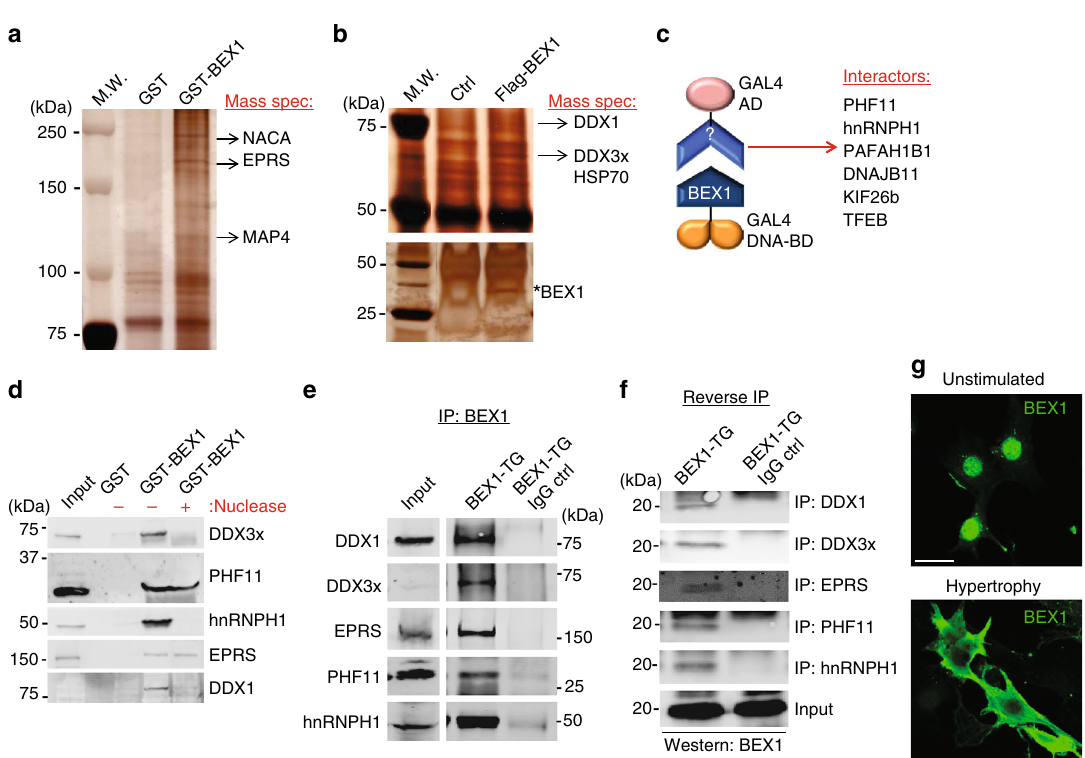
Fig. 3 Annotating the BEX1 protein interactome. a Silver-stained polyacrylamide gel following GST-only or GST-BEX1 pull-down from cardiac protein extracts. Arrows indicate the binding proteins identi fi ed by mass-spectrometry. b Silver-stained polyacrylamide gel following control or Flag-BEX1 immunoprecipitation from neonatal rat cardiomyocytes protein extracts. Arrows indicate the binding proteins identi fi ed by mass-spectrometry. c Schematic of the employed yeast two-hybrid screening strategy. The arrow shows the list of binding proteins identi fi ed. d Western blot following GST-BEX1 pull-down of the indicated proteins from cardiac extracts of WT hearts with or without addition of micrococcal nuclease to degrade RNA. e Western blot for the indicated 5 proteins following immunopreciptation of BEX1 protein from BEX1 transgenic hearts. Input is shown on the left and anti-BEX1 or IgG was used for the immunoprecipitations. f Western blot for BEX1 protein from a BEX1 transgenic heart after immunoprecipitation of the 5 shown endogenous proteins. The input is shown on the bottom and the IgG control is shown in the right lanes. g Immuno fl uorescence for BEX1 (green) in neonatal rat cardiomyocytes in unstimulated (serum-free media) or hypertrophic conditions (media containing 2% serum). Original magni fi cation is 100×. Scale bar is 20 µ m. Abbreviations: DDX3x = DEAD box helicase 3 X-linked; DDX1 = DEAD box helicase 1; hnRNPH1 = heterogeneous nuclear ribonucleoprotein H1; PHF11 = PHD-containing factor 11; HSP70 = heat shock protein 70; TFEB = transcription factor EB; NACA = Nascent Polypeptide-Associated Complex Alpha Subunit; EPRS = Glutamyl-Prolyl-tRNA Synthetase; DNAJB11 = DnaJ Heat Shock Protein Family Member B11; PAFAH1B1 = Platelet-Activating Factor Acetylhydrolase 1b Regulatory Subunit 1; KIF26b = Kinesin Family Member 26b; MAP4 = Microtubule-Associated Protein 4. All the gels show